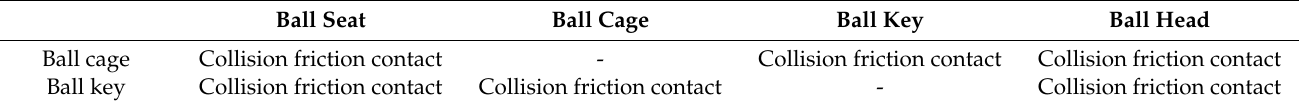
Figure 10. Multi-body dynamics model of flexible joint. The material of the flexible joint is 35 CrMo, the density is 7850 kg/m 3 , the Young’s modulus is 210 GPa, and the Poisson’s ratio is 0.3. According to the working principle of the flexible joint, the rotation pair constraint and the driving speed of 100 r/min were imposed on the ball seat, and the rotation pair constraint and the resistance torque of 1.8 kN.m were imposed on the ball head. The internal contact settings of each component of the flexible joint are shown in Table 1. Table 1. Contact relationship between components of flexible